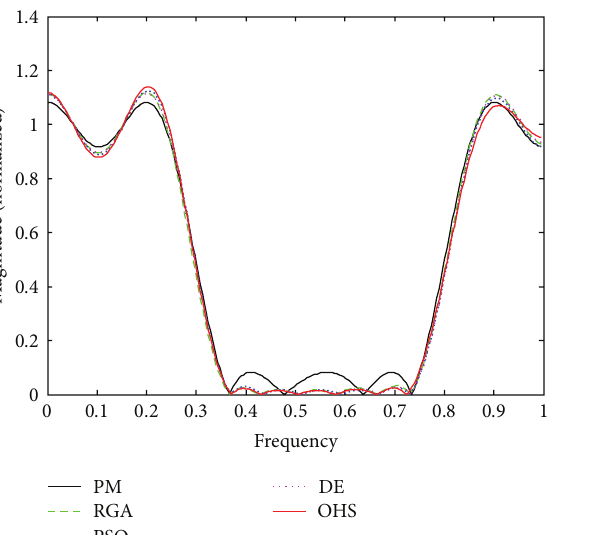
Figure 16: Normalized stop band ripple plot for the FIR BS filter of order 20.